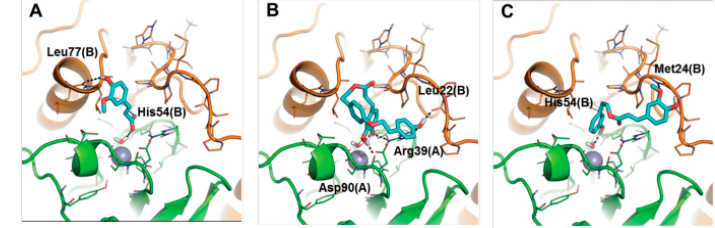
Figure 26. Predicted binding mode of 2 (panel A ), 4 (panel B ) and 8 (panel C ) towards the active site of Rv1248 β -CA from Mtb. Monomer A is colored green, monomer B is colored orange. Small molecules are shown as cyan sticks. Residues within 5 Å from the Zn(II) ion and those in contact with the inhibitors are shown as lines. H-bond interactions are highlighted by black dashed lines. Residues involved in H-bonds are labeled. The catalytic Zn(II) ion is shown as a grey sphere [85].